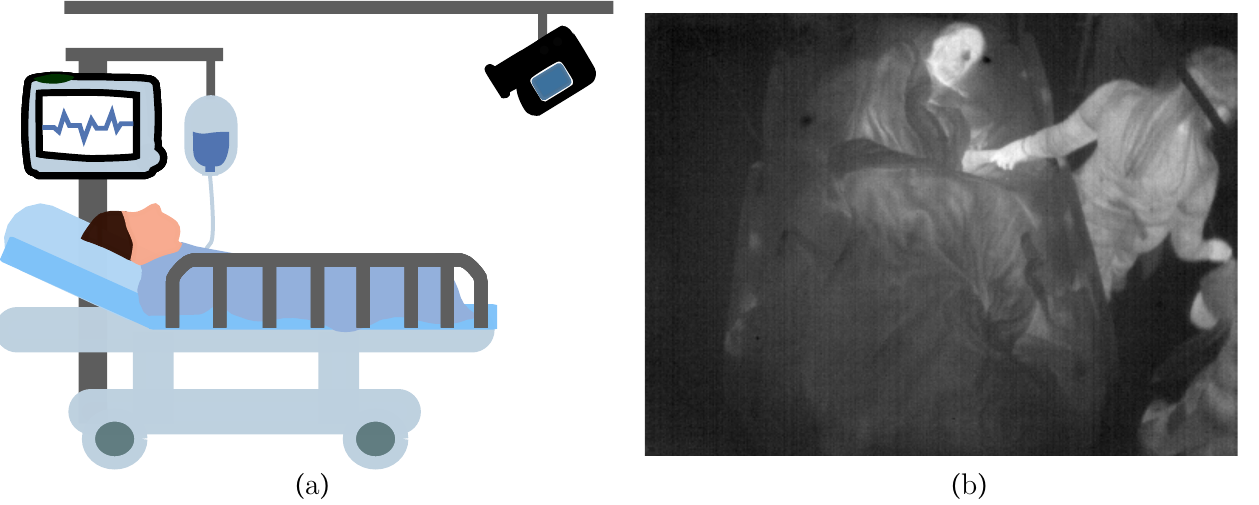
Figure 1. ( a ) Measurement setup in the intensive care unit (ICU) with an infrared camera attached to the ceiling. ( b ) Example infrared frame from